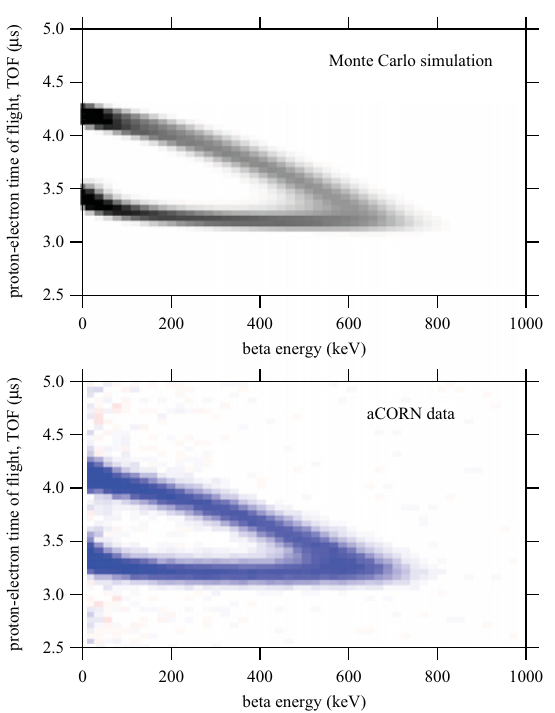
Figure 1. The aCORN “wishbone” histogram plot of proton time of flight vs. beta energy for delayed coincidence neutron decay events. Top: a Monte Carlo simulation using the aCORN geometry, with uniform axial magnetic and electric fields, a Gaussian energy resolution function, and and perfect (delta function) time resolution. Bottom: A sample of aCORN data. Blue pixels are positive and red are negative (due to the background subtraction).